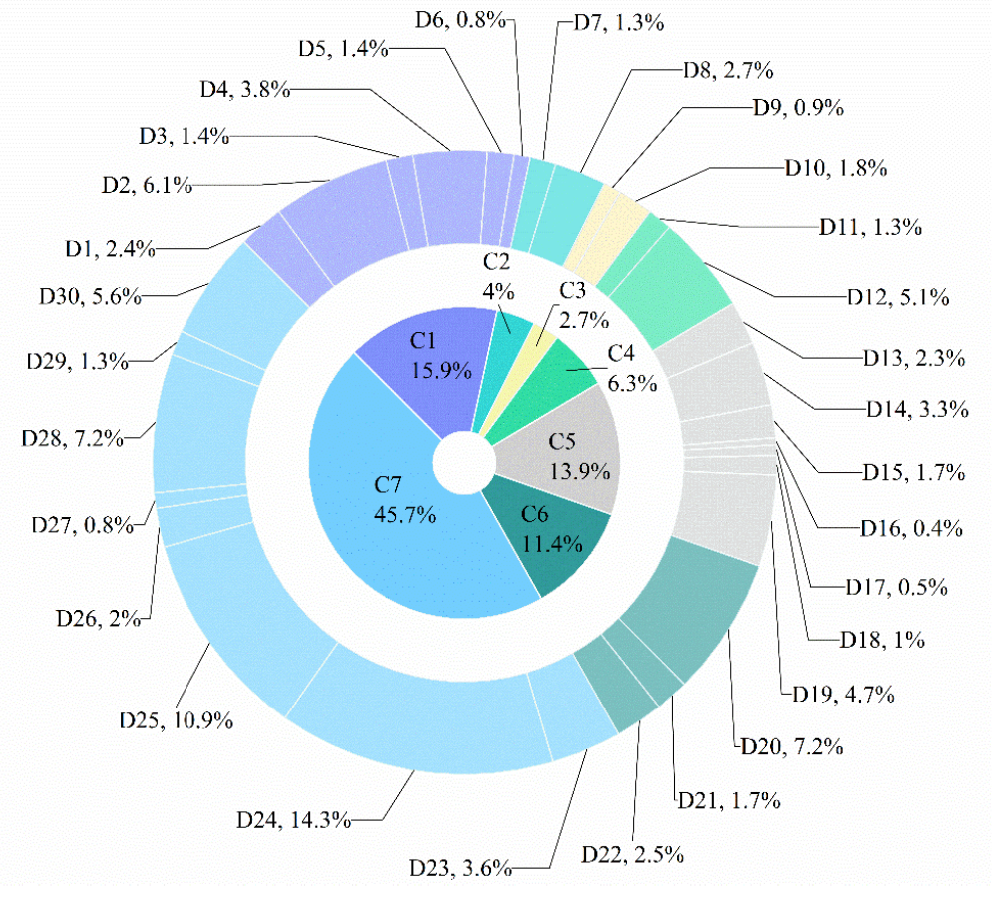
Figure 5. Weight values of all indices affecting the effective utilization coefficient of irrigation wa- ter.